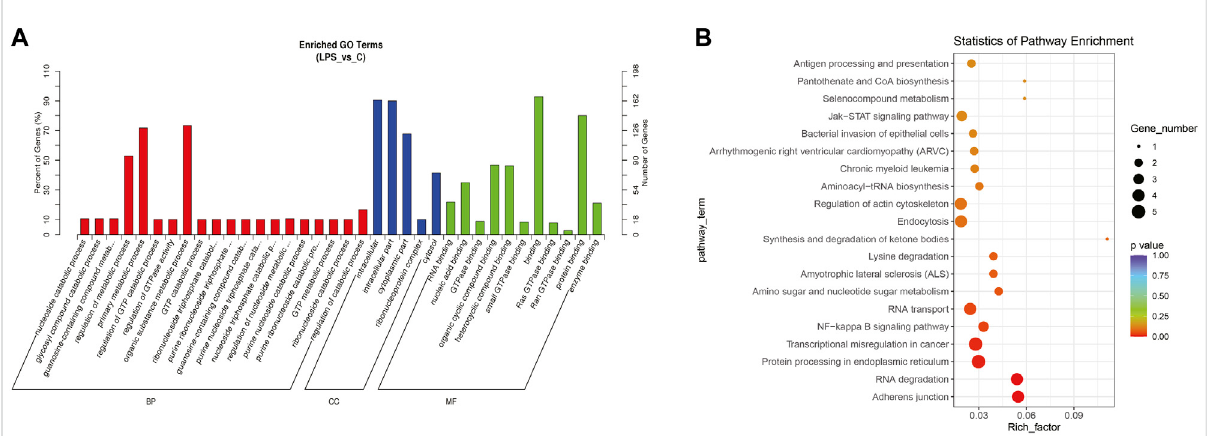
FIGURE 2 GO and KEGG pathway enrichment analyses for DE circRNAs. (A) The top signi fi cantly enriched GO terms for DE circRNAs. The horizontal axis representsthenameoftheGOterm,and thevertical axisrepresentsthenumberofgenes. (B) Thetop20signi fi cantly